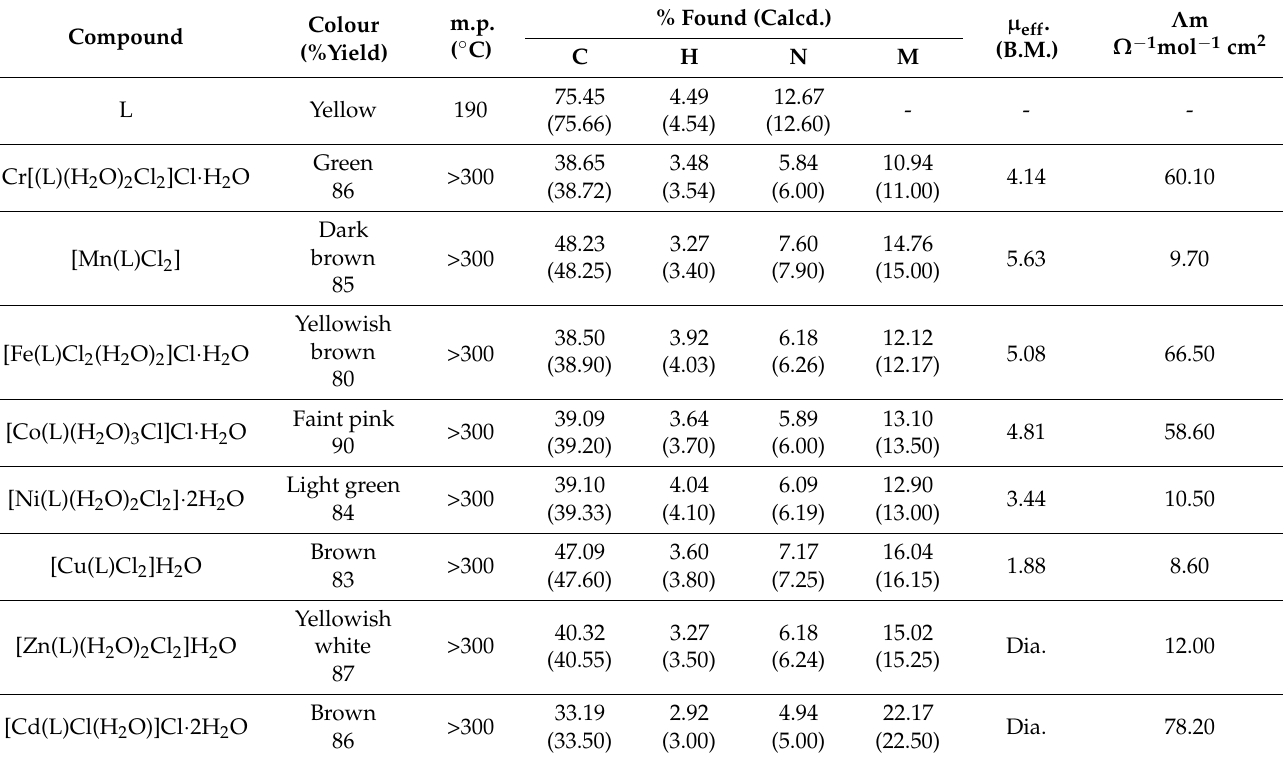
Table 1. Schiff base ligand and its metal complex analytical and physical